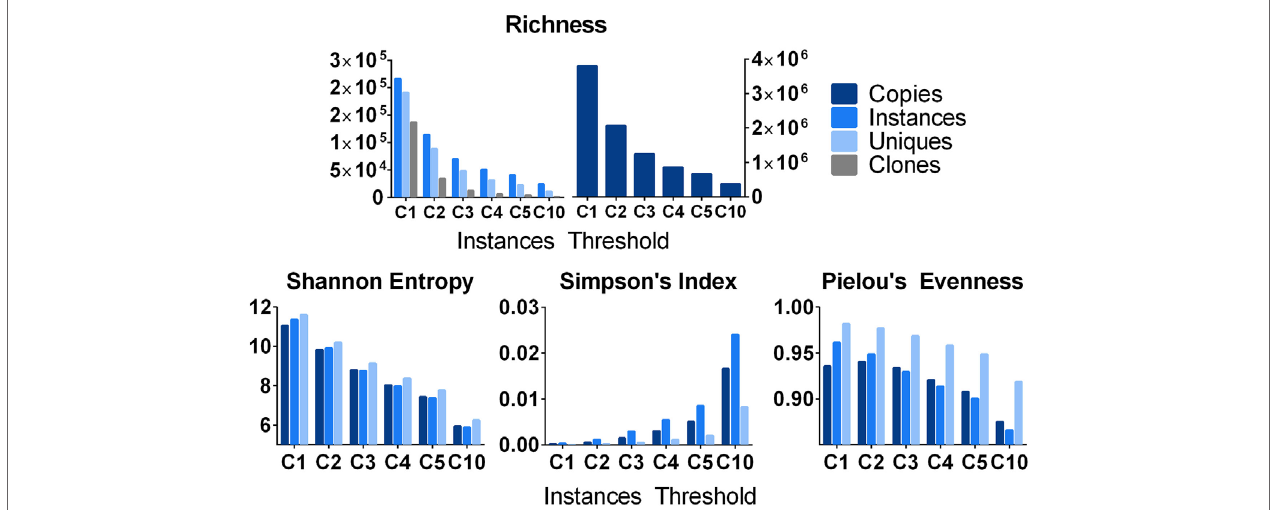
FIgUrE 7 | Various metrics of diversity and evenness. Count: the total number of clones and the number of instances, unique sequences, and copies that comprise them. Shannon Diversity: the Shannon diversity of clones when their size is defined as instances, unique sequences, and copies. Pielou’s Evenness: measures how evenly distributed clone sizes are. A value of 1 indicates all clones are of the same size, and a value of 0 indicates maximal diversity in size. It is defined as the Shannon Diversity divided by the maximal diversity [equal to ln( S )] where S is the number of clones. Simpson index: diversity at Hill order 2. This can be interpreted as the probability of randomly drawing two copies/instances/unique sequences that belong to the same